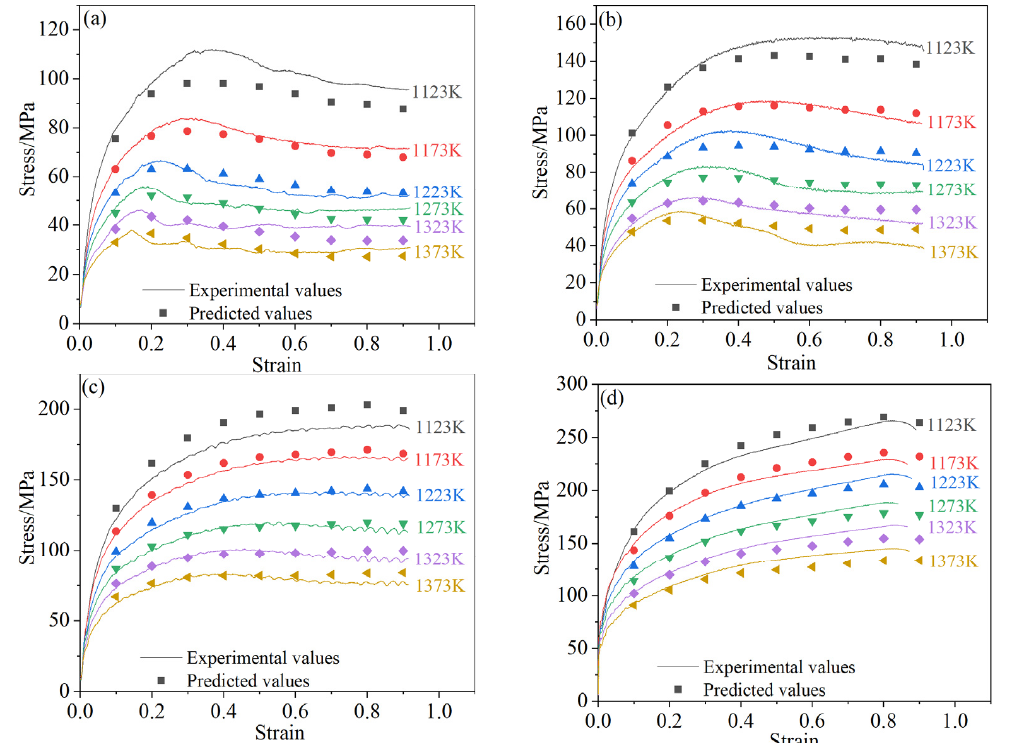
Figure 10. Comparison between predicted and experimental flow stress using Strain-compensated Arrhenius model at different strain rates: ( a ) 0.01 s − 1 ; ( b ) 0.1 s − 1 ; ( c ) 1 s − 1 ; ( d ) 10 s − 1 .